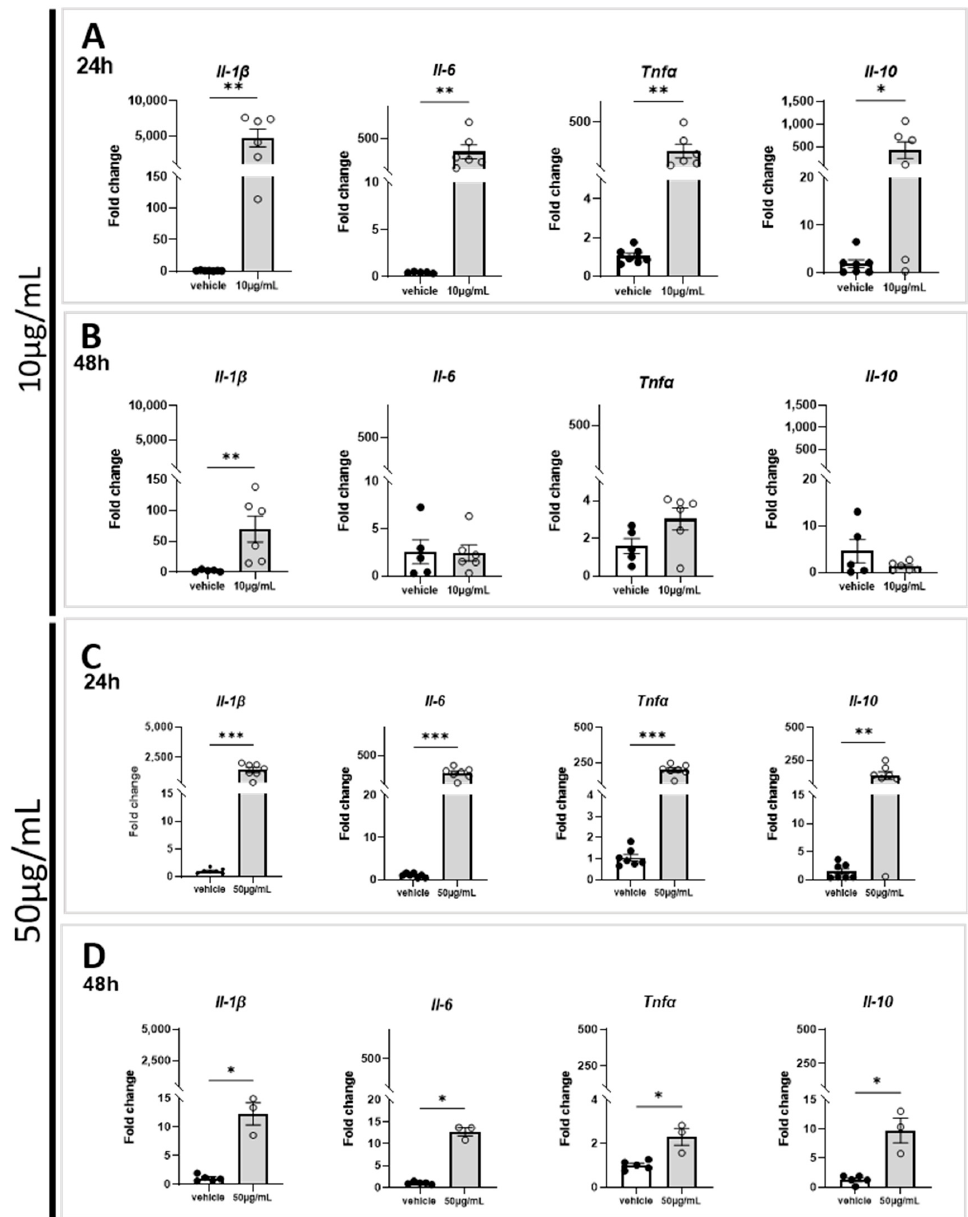
Figure 2. Effects of 10 and 50 µ g/mL of marennine on gene expression in astrocytes and microglial cells after 24 h and 48 h of treatment. Levels of gene expression Il-1 β , Il-6 , Tnf α and Il-10 after marennine exposure were measured by RT-qPCR. ( A ) After 24 h of marennine with 10 µ g/mL. ( B ) After 48 h of marennine with 10 µ g/mL. ( C ) After 24 h of marennine with 50 µ g/mL. ( D ) After 48 h of marennine with 50 µ g/mL. At 10 µ g/mL, for 24 h Il-1 β : vehicle n = 5, marennine n = 6; Il-6 : vehicle n = 7, marennine n = 6; Tnf α : vehicle n = 7, marennine n = 6; Il-10 : vehicle n = 7, marennine n = 6. For 48 h Il-1 β : vehicle n = 5, marennine n = 6; Il-6 : vehicle n = 5, marennine n = 6; Tnf α : vehicle n = 5, marennine n = 6; Il-10 : vehicle n = 5, marennine n = 6. 50 µ g/mL, for 24 h Il-1 β : vehicle n = 7, marennine n = 7; Il-6 : vehicle n = 7, marennine n = 7; Tnf α : vehicle n = 7, marennine n = 7; Il-10 : vehicle n = 7, marennine n = 7. For 48 h Il-1 β : vehicle n = 5, marennine n = 3; vehicle n = 5, marennine n = 3; Tnf α : vehicle n = 5, marennine n = 3; Il-10 : vehicle n = 5, marennine n = 3. Values represent mean ± SEM. Statistical differences from the control are indicated as follows: * p < 0.05; ** p < 0.01; *** p < 0.001 using Mann–Whitney